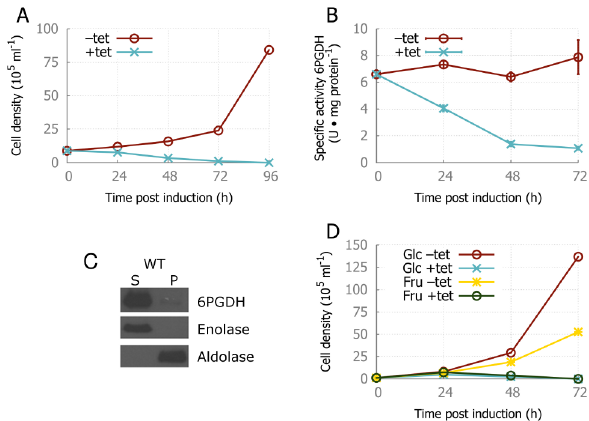
Figure 6. Ablation of 6PGDH. ( A ) Effect of 6PGDH ablation on the growth rate. A non-induced 6PGDH RNAi culture, grown in glucose- containing HMI-9 was split at 0 h, + tet is induced with tetracycline, while 2 tet is the non-induced control. (B) Specific activities of 6PGDH in induced and control 6PGDH RNAi parasites. (C) Western blot showing predominant co-localization of 6PGDH with the glycosomal marker aldolase (fraction S), while a faint band can also be observed in the cytosolic fraction P with the marker enolase. (D) Cell densities during growth on different substrates. At t =0 h, a 6PGDH RNAi culture grown on glucose was split at 1 ? 10 5 ml 2 1 to HMI-9 with either glucose or fructose, and in the absence and presence of tetracycline. Plotted cell densities are cumulative, as 2 tet cultures were split at 48 h to 1 ? 10 5 ml 2 1 . A higher starting cell density was used to allow the parasites to adapt to the change in carbon source. Growth on fructose is slower than on glucose, but is unable to rescue the induced cultures.